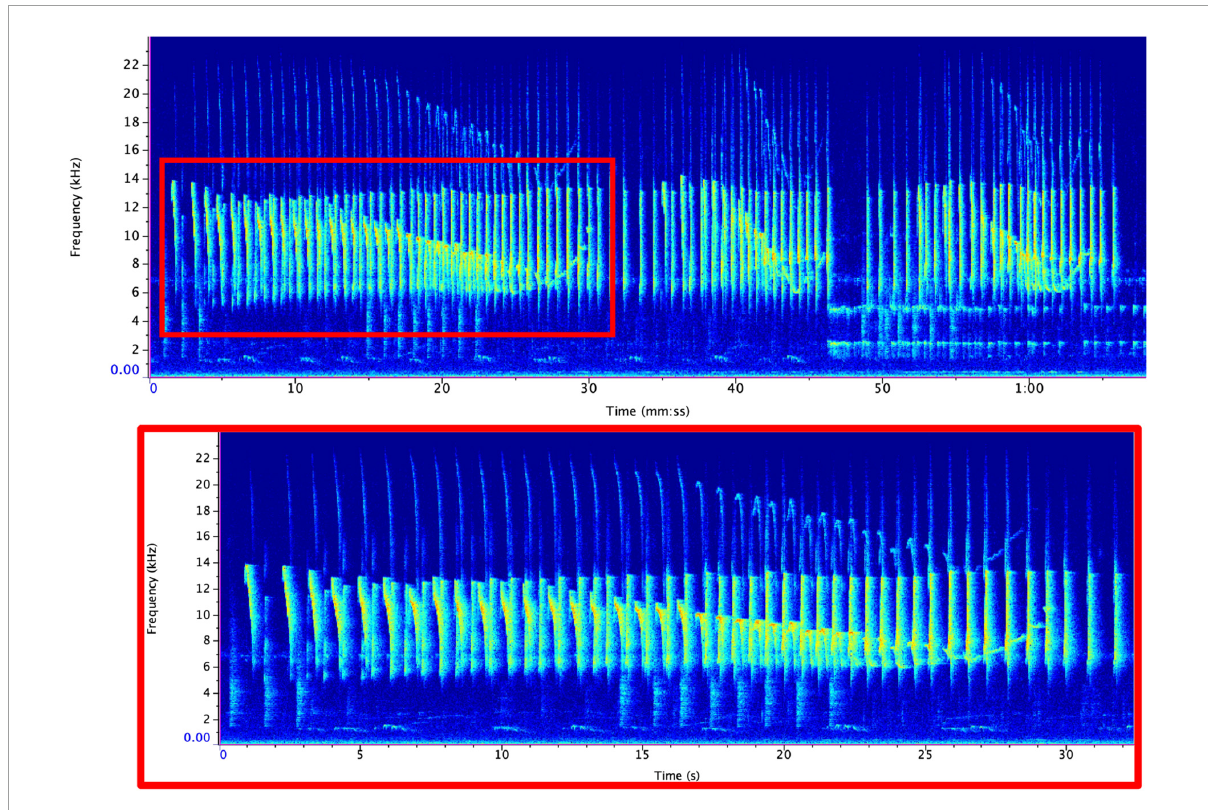
FIGURE2 Representative spectrogram of a tarsier duet (top) and phrase (bottom) . A single duet (top) can be comprised of many phrases (bottom) . Phrases can vary in length but generally follow the structure shown above. Spectrograms were created using RavenPro with the same settings that were used for analysis (see text for details).